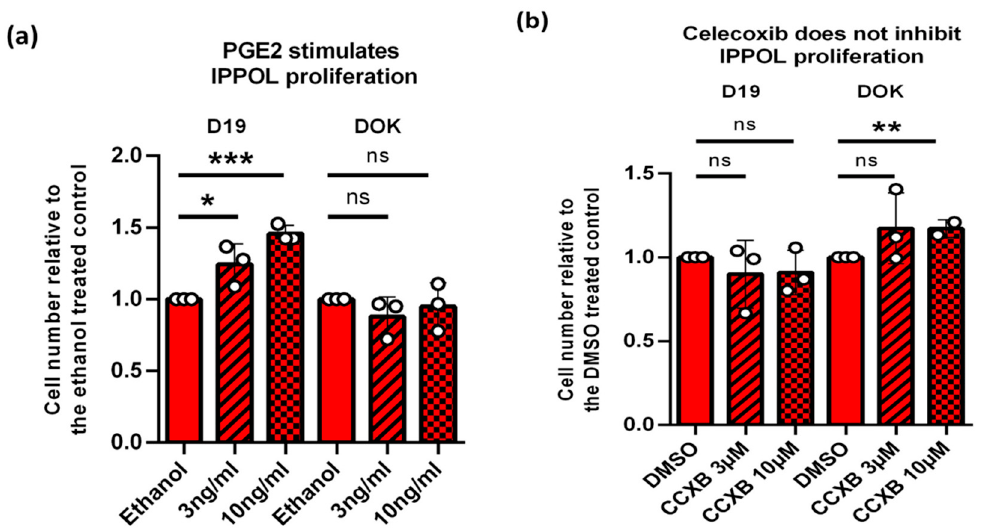
Figure 10. Exogenous PGE2 (3 ng/mL striped bars; 10 ng/mL dotted bars) stimulates the proliferation of some IPPOL lines. ( a ) Shows the effect of a 10-day treatment of IPPOL lines D19 and DOK relative to the ethanol vehicle control +/ − standard deviation. ( b ) Shows the effect of the COX-2 selective inhibitor celecoxib (CCXB) on the same lines at 3 µ M (striped bars) and 10 µ M (dotted bars). * p < 0.05; ** p < 0.01; *** p < 0.001 by Student’s t test. The data show that only exogenous PGE2 stimulates D19 proliferation.